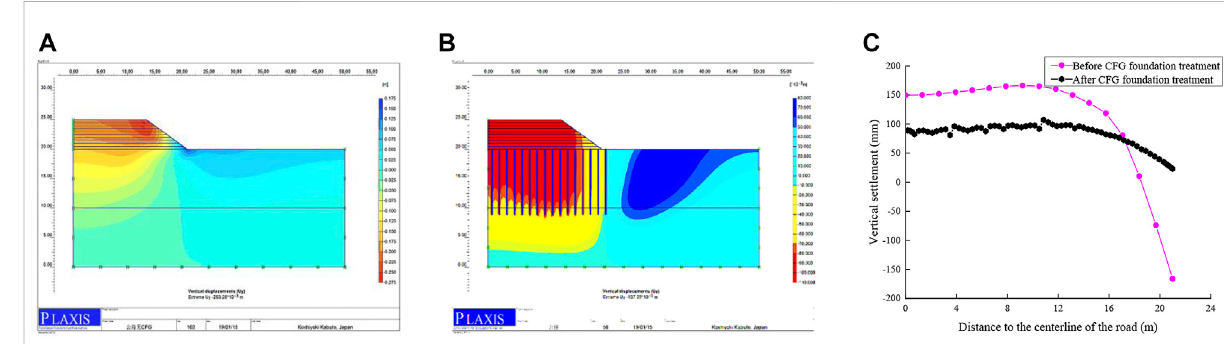
Settlement calculation results before and after foundation treatment: (A) Vertical settlement of the road without foundation treatment; (B) Vertical settlement of the road after CFG pile foundation treatment; (C) Distribution of vertical settlement of pile top along the width of the embankment before and after foundation